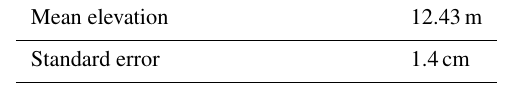
Table 1. Test statistics of the gridded elevation values on the paved area, which is assumed to be stable throughout the observation pe- riod of 1 month. Values are calculated per time series and averaged over the entire stable area, which results in mean elevation, standard error and an average 95th percentile of deviations from the mean. Mean elevation 12.43m Standard error